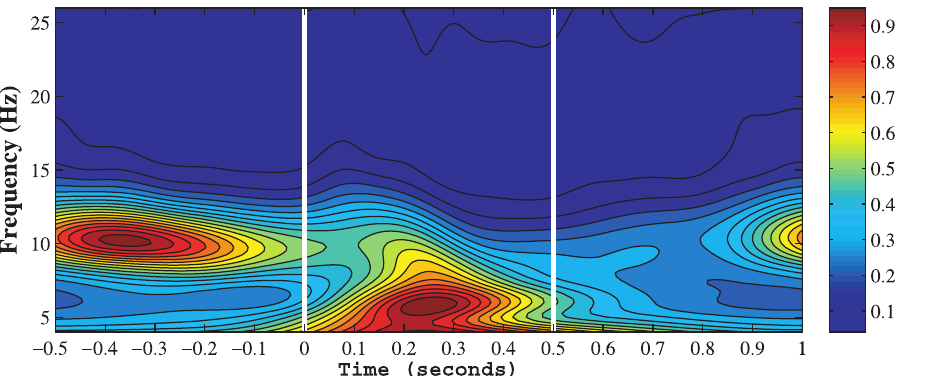
Figure 3. Wavelet power spectrum of a typical subject averaged over all trials and electrodes in normalized power units. The stimulus onset time is at 0 ms.